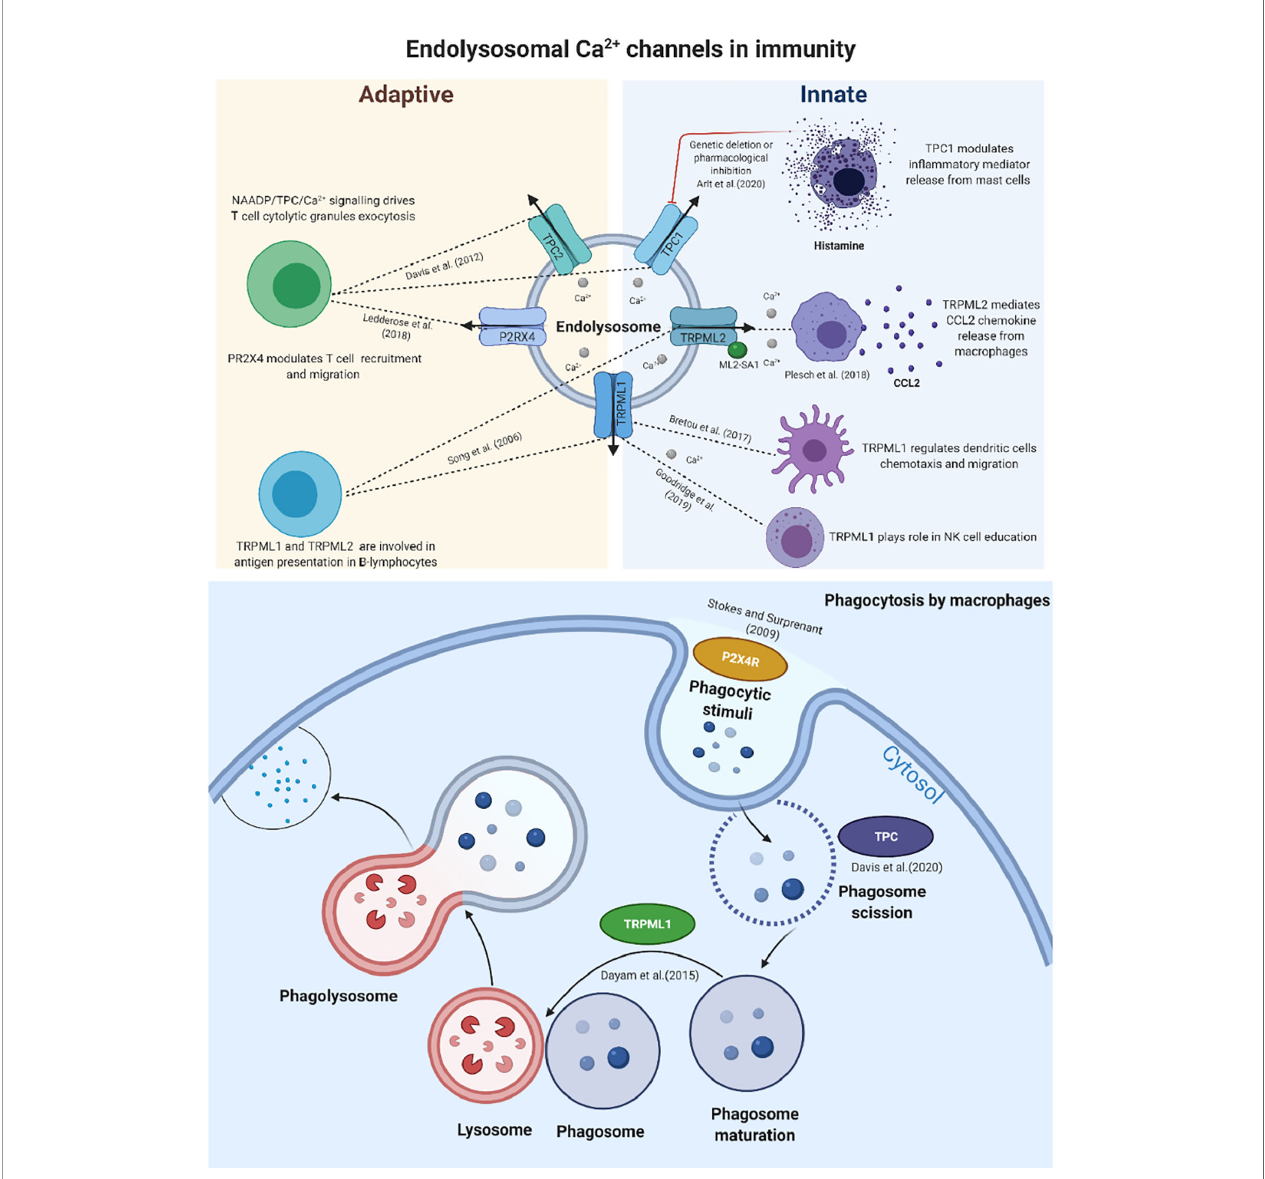
FIGURE 1 | Schematic representation of the main calcium endolysosomal Ca 2+ channels involved in immunity. The evolving contributions of TPCs, TRPMLs and P2X 4 R in innate and adaptive immune responses and their vital roles in various stages of